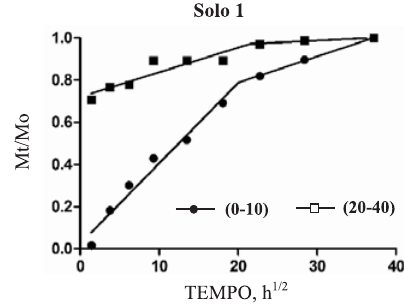
Figura 5. Cinética de liberação de Pb [equação parabólica de difusão (Mt/Mo = a + kt 1/2 )] da amostra de referência dos teores naturais de metal, em área localizada no município de